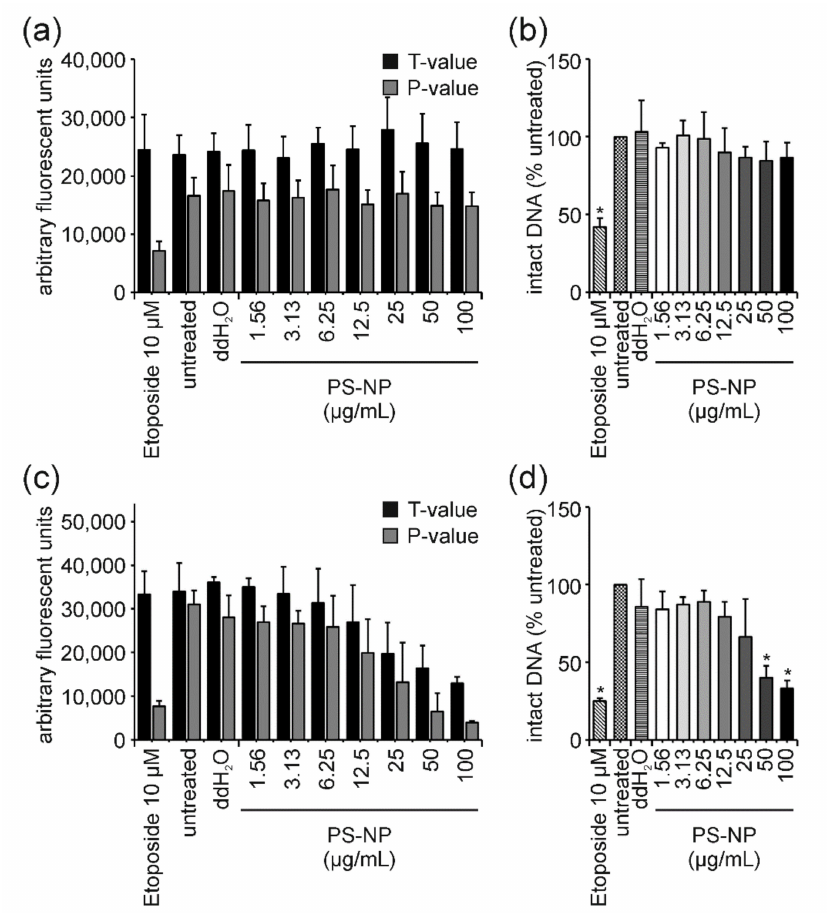
Figure 7. Influence of PS-NPs on T- and p -values in the FADU assay and corresponding interfer- ence correction . Following 3 h ( a , b ) and 24 h ( c , d ) of exposure of Jurkat E6-I cells to PS-NP, the FADU assay was performed. After 3 h of incubation, only p -values decreased dose-dependently ( a ), while after 24 h, T- and p -values decreased with increasing PS-NP concentrations ( c ). Results following interference correction for the 3-h ( b ) and 24-h ( d ) time point are shown. Data shown repre- sent the mean of at least three independent experiments and the corresponding standard deviation. (* p ≤